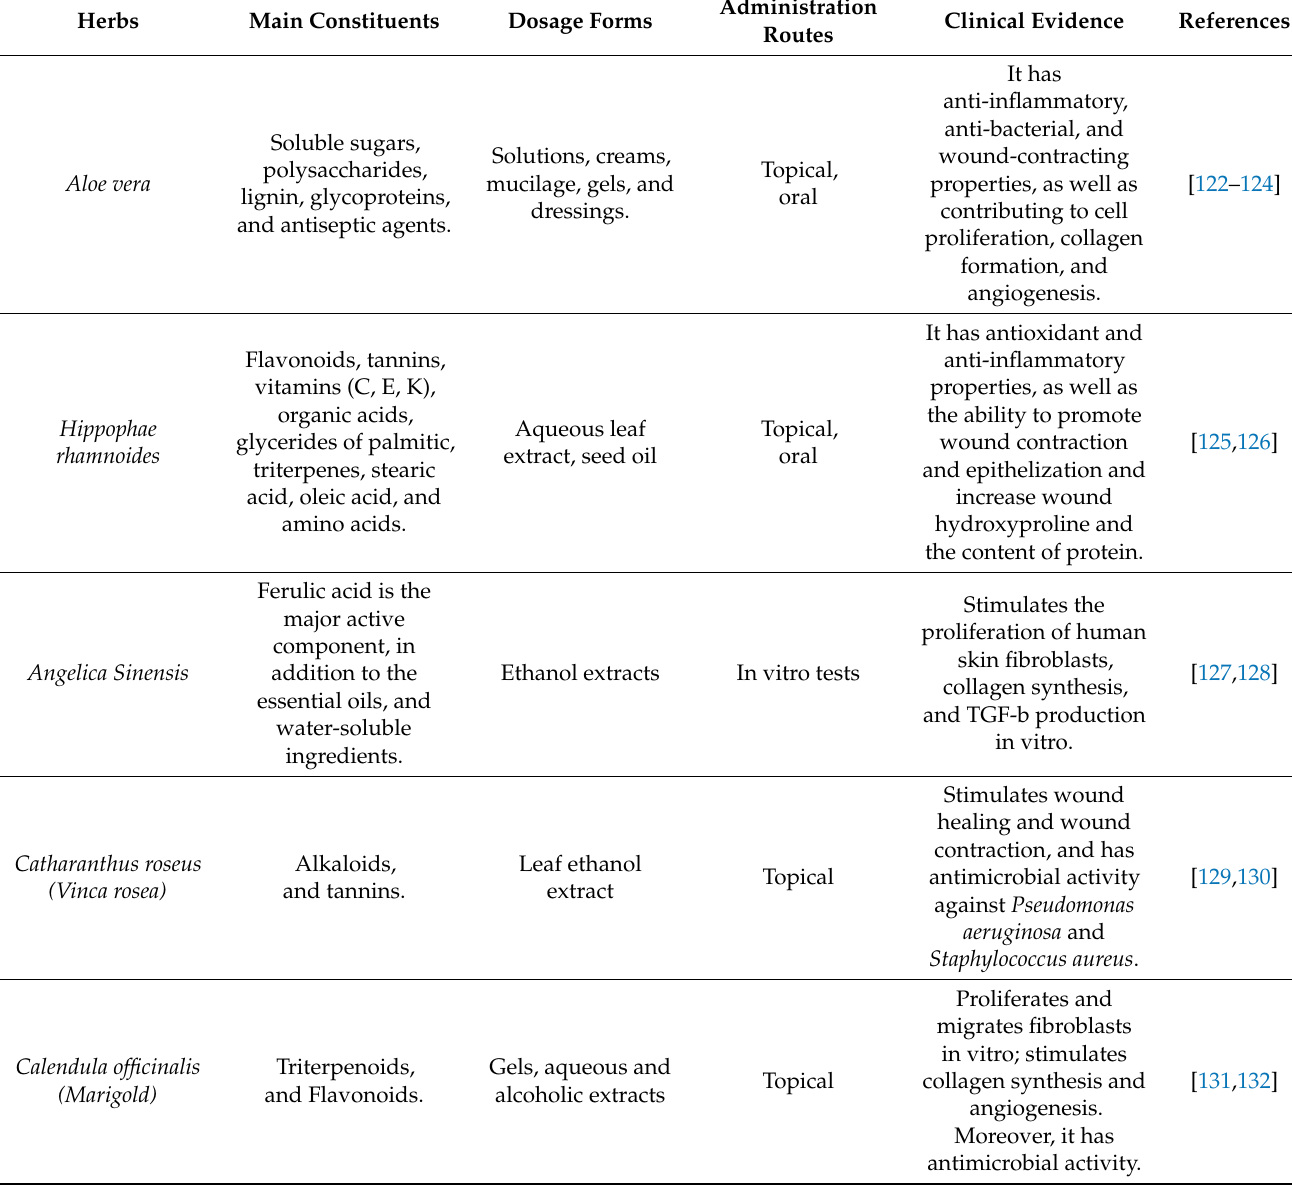
Table 9. Uses of natural herbs in burn